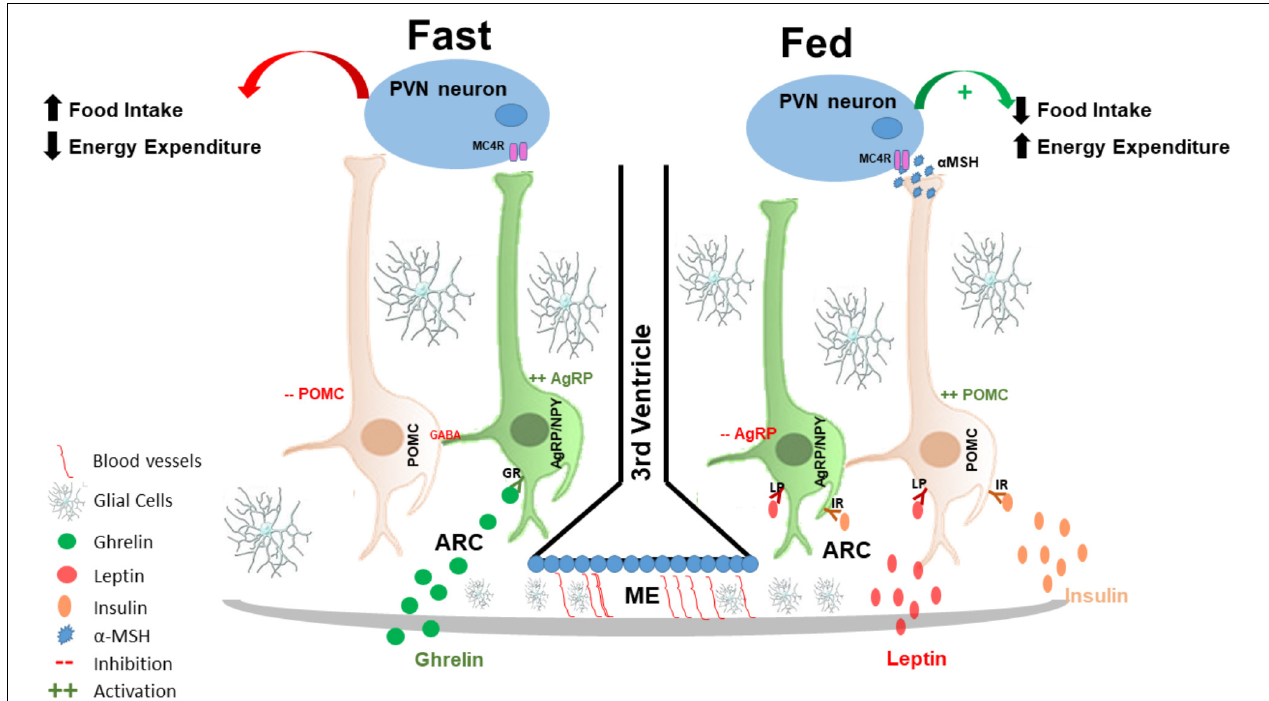
FIGURE 1 | Hypothalamic regulation of energy homeostasis: the hypothalamus senses and integrates peripheral adipostatic hormones that circulate in levels proportionate to nutritional status and adipose tissue stores. Under fasting conditions ghrelin, secreted by the stomach, binds to its receptor in AgRP neurons in the ARC, leading to its activation. AgRP neuronal activation increased the release of AgRP that is an antagonist of MC4R in the PVN neurons; at the same time, AgRP neurons also release of GABA neurotransmitter that inhibited POMC neurons, and consequently increasing appetite and decreased energy expenditures. In the fed state, insulin and leptin act directly on their receptors, both in POMC and AgRP neurons in the ARC of the hypothalamus to control energy homeostasis; insulin and leptin induce inhibition of AgRP and activation of POMC neurons. POMC neuronal activation involves the processing of POMC with formation of α -MSH that is an agonist of MC4R and consequently activating PVN neurons. PVN activation culminates in satiety (decreased food intake) and stimulation of energy expenditure. AgRP, agouti related protein; MC4R, melanocortin 4 receptor; GABA, gamma-aminobutyric acid; POMC, proopiomelanocortin; α -MSH, alpha-melanocyte-stimulating hormone; PVN, paraventricular